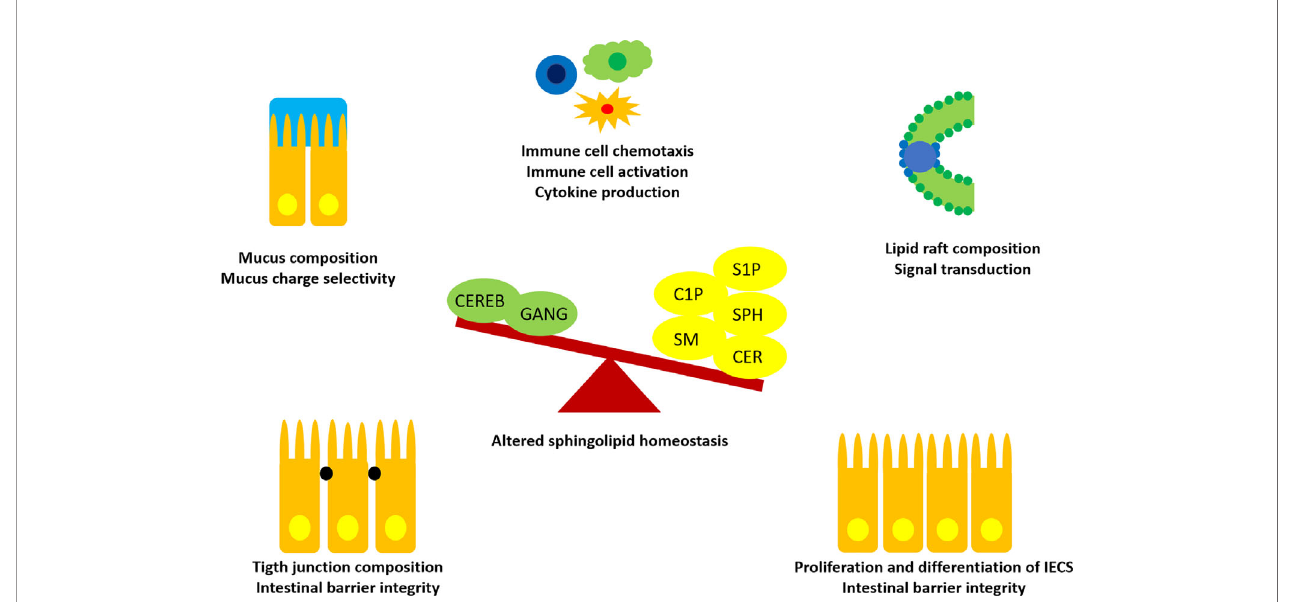
FIGURE 3 | In fl uences of SLs in intestinal homeostasis. Recent fi ndings suggested an imbalance of SLs and metabolites in favor of S1P, C1P, Cers (CER), Sph, SM, instead of more complex cerebrosides (CEREB) and gangliosides (GANG) to promote intestinal in fl ammation. SLs are able to interact with IECs and immune cells at different sites. Thus, SLs are promising candidates for treatment of immune-mediated diseases and as predictive